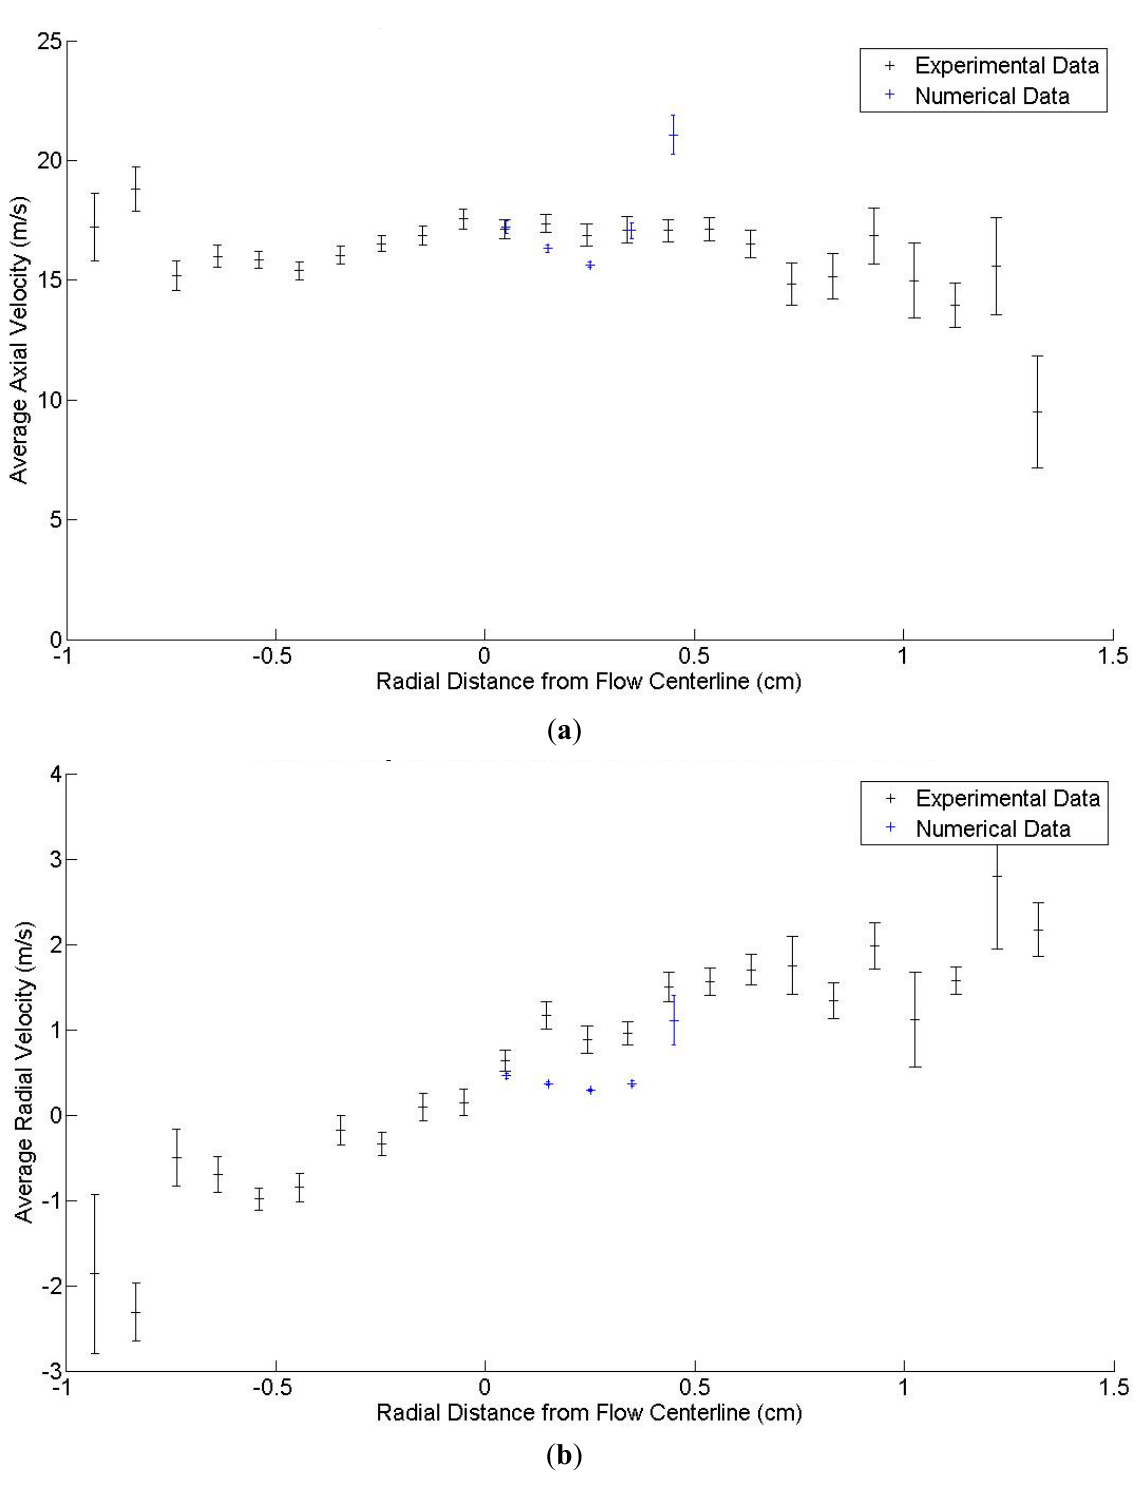
Figure 22 . Experiment 1: Comparison of the experimental and numerical values of the particle ( a , c ) axial and ( b , d ) radial velocities at ( a , b ) z = 100 mm and ( c , d ) z = 200